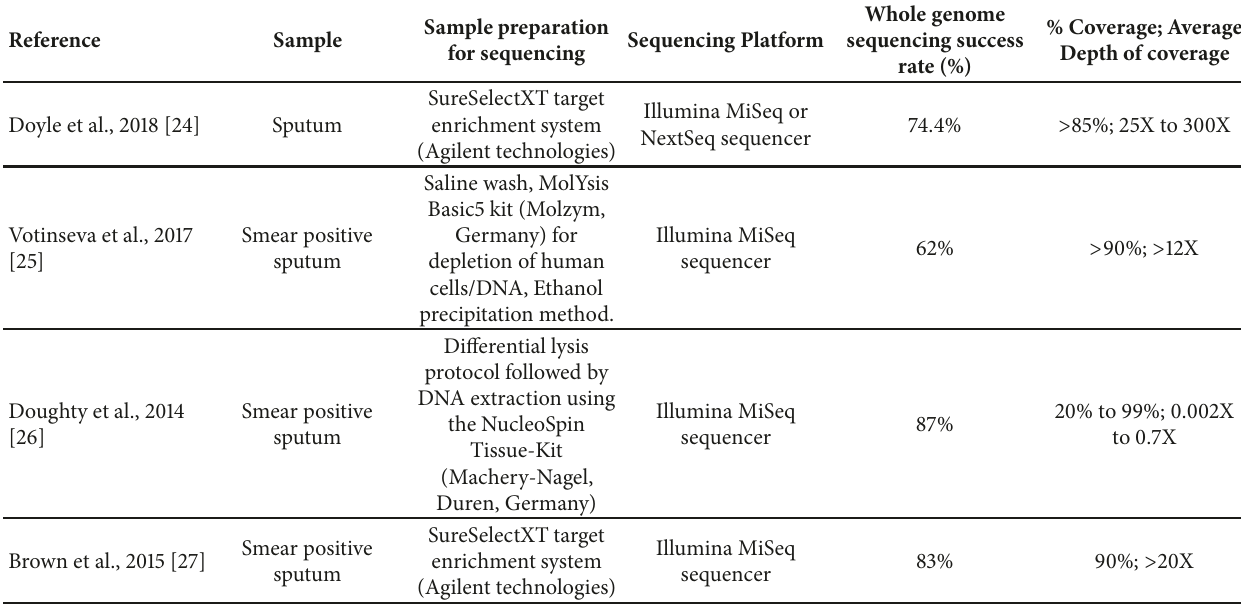
Table 2: Summary of methods developed for DNA extraction directly from sputum samples for M. tuberculosis next-generation whole genome sequencing.